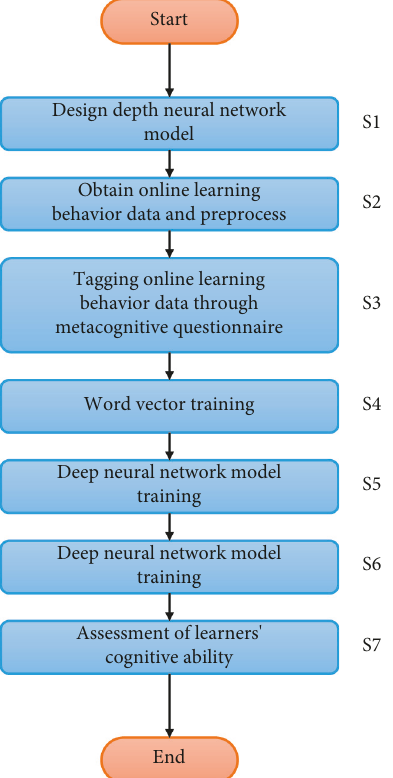
Figure 9: Learning behavior assessment.